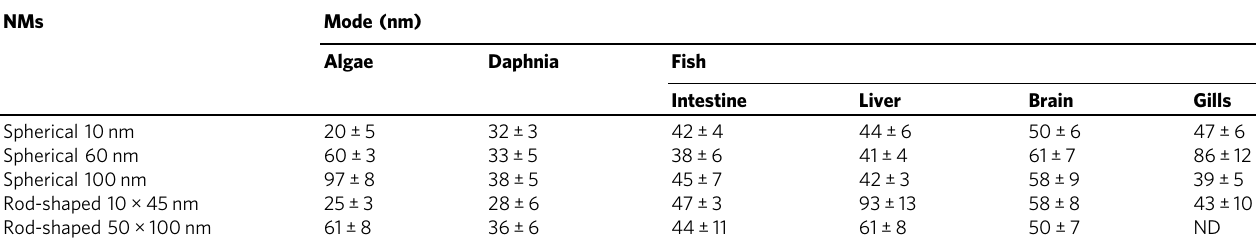
times diluted with PBS; containing 4.5 g L − 1 proteins) for 24 h (Fig. 2b and Supplementary Section 8). After incubation, the samples were digested using Tetramethylammonium hydroxide (TMAH) to remove the biomolecules and free the Au ions potentially sorbed to these molecules (for detailed information about the method see Supplementary Section 8). The residuals were measured using spICP-MS to differentiate between Au ions and Au-NMs. The results (Fig. 2c) showed that the biomolecule